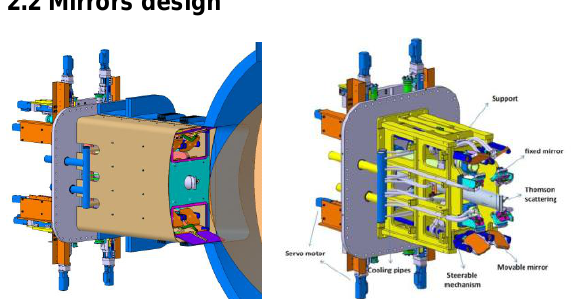
Fig. 3. (Left) Illustration of the 4MW front steering equatorial launcher design, (Right) Configuration of the launcher The focusing mirror, at angle of 45 ° with respect to beam size for the higher localized current drive.